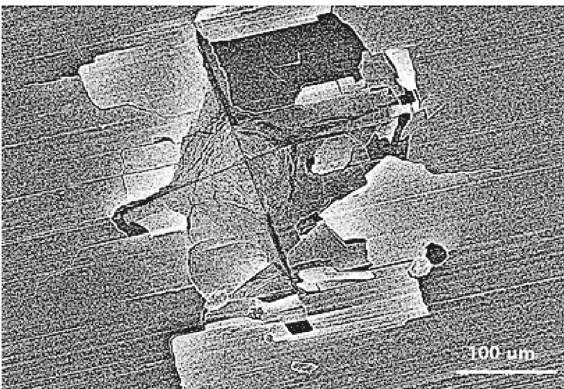
Figure 8: SEM image of the nanoindentation